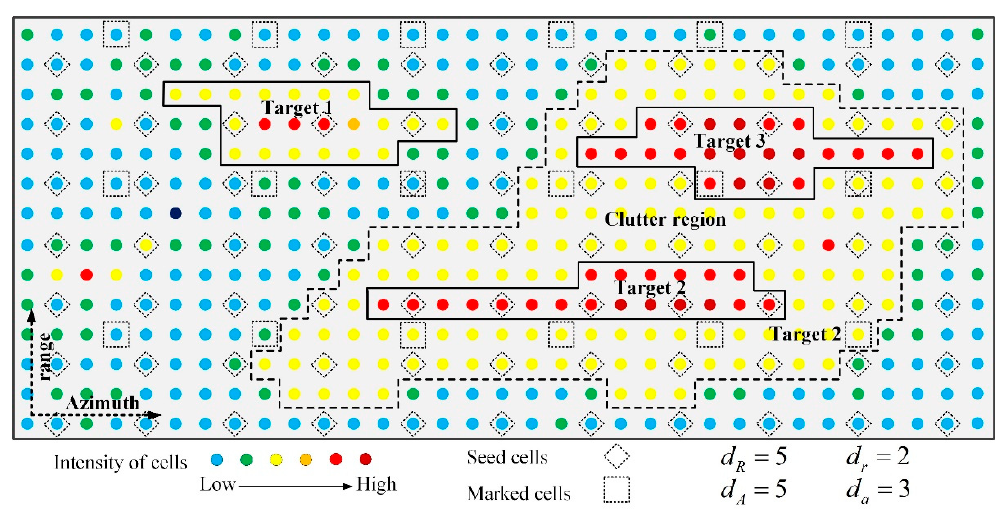
Figure 4. A sample of the spatiotemporal thresholding method.